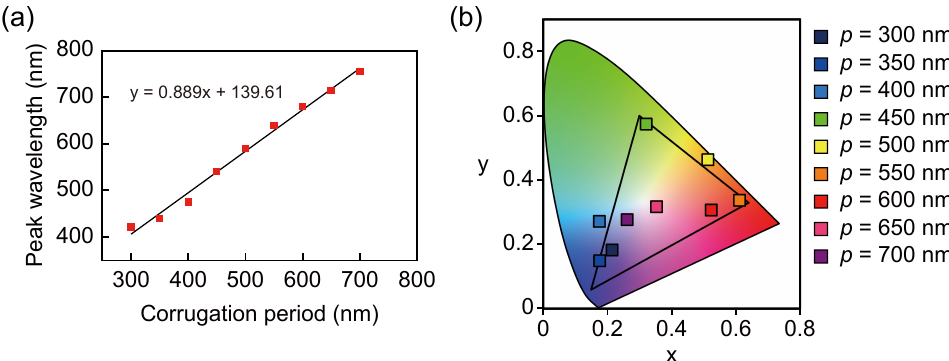
Figure 5. ( a ) The peak transmitted wavelength as a function of the corrugation pitch in 50-nm steps and ( b ) the CIE1931 XY chromaticity diagram of the measured transmission